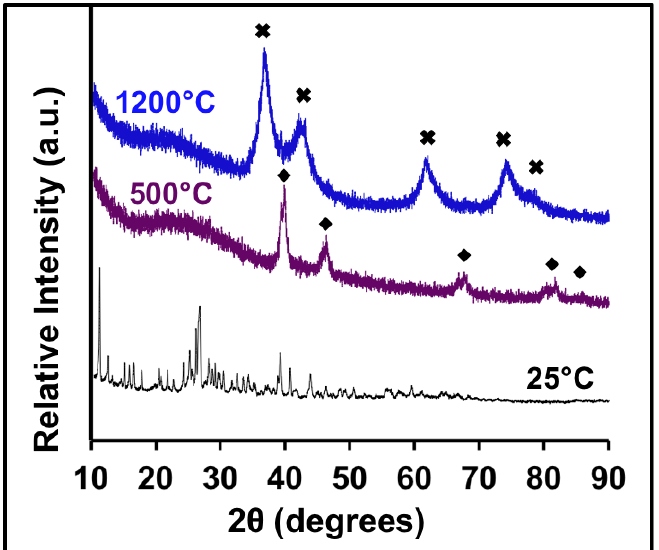
Figure 4. XRD of Pd and Mo ternary carbides at 25 °C (black), 500 °C (purple), and 1200 °C (blue). The symbols for ( ◆ ) Pd in the figure are based on JCPDS files Pd46-1043, and PdMoC ( ✖ ) does not have a reported structure.